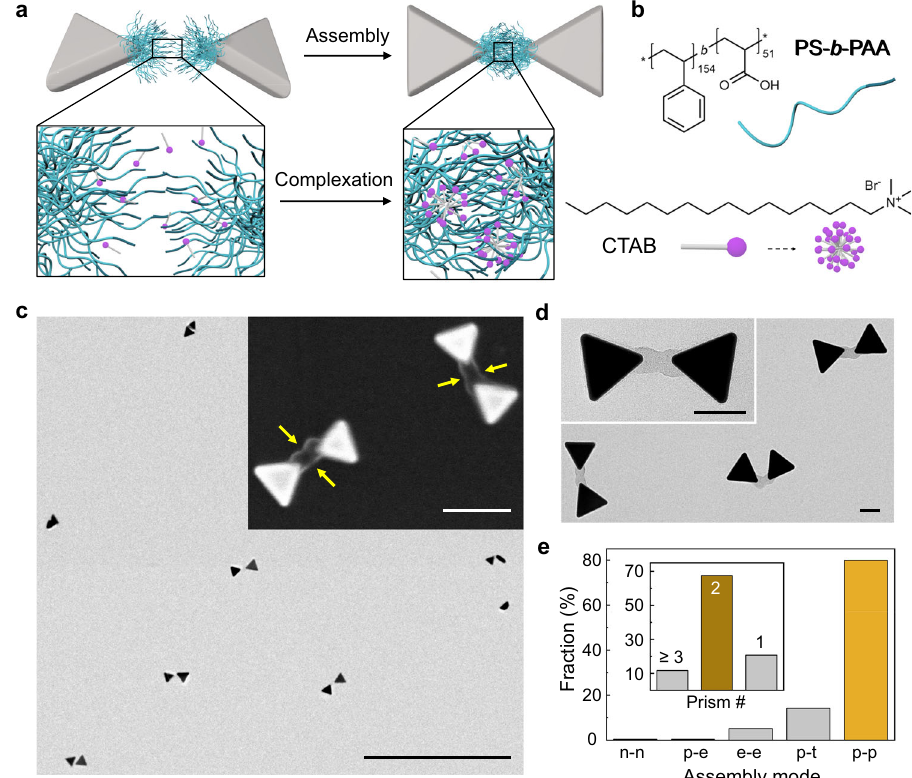
Fig. 5 | Patch-to-patch selective assembly of single-patch prisms. a Schematics of the CTAB-induced patch complexation mechanism. b Chemical structure of PS- b -PAA and CTAB involved in patch-patch selective assembly. c Low magni fi cation TEM and scanning electron microscopy (SEM) (inset) images of dimers. Yellow arrows highlight the merged patch interface. d High magni fi cation TEM images of patch-patchassembleddimers. e Yieldsofassemblymotifsindimers.Thenotations